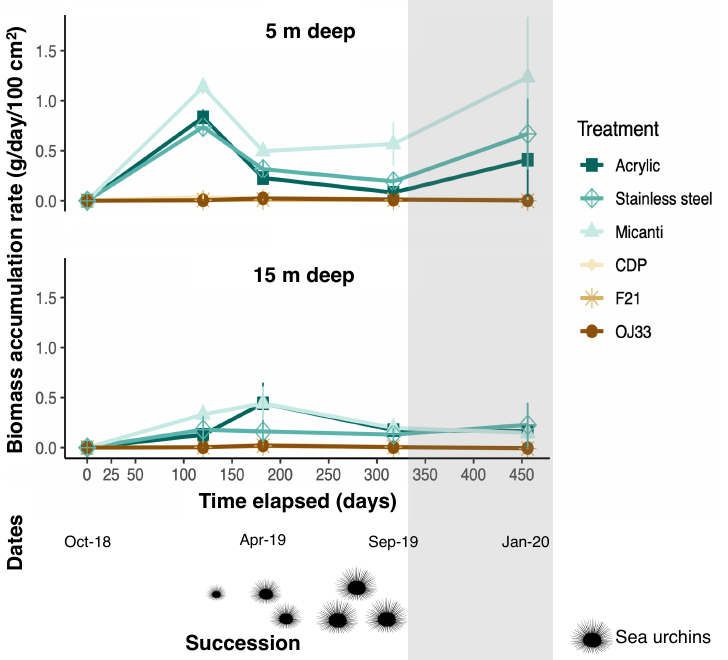
Figure 2. Biofouling biomass accumulation rate (g/day/cm 2 ± SE) in the 100 cm 2 plates recorded during 15 months at the two depths of deployment. Plates were replaced. The bottom scheme shows when sea urchin recruits were first observed in the experimental moorings, and when they grew and increased in abundance on the plates. The shading shows biomass trajectories after sea urchin manual removal on day 317 of the